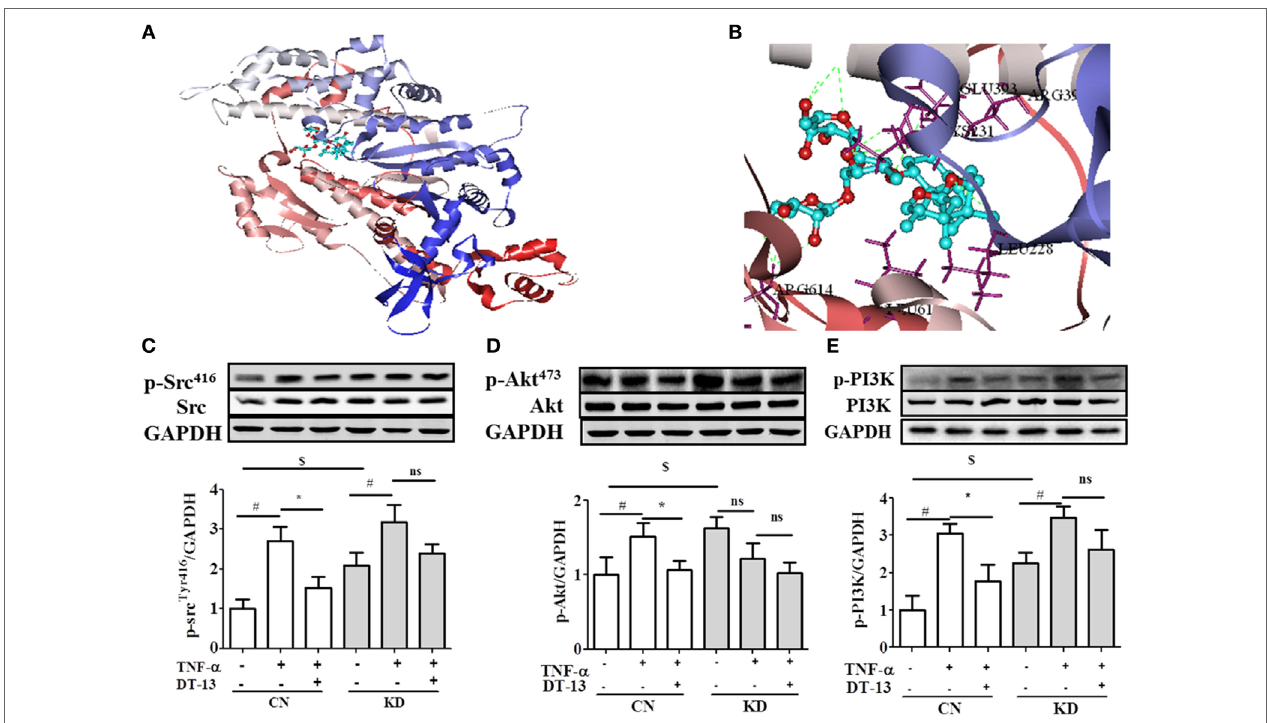
FigUre 6 | Non-muscle myosin IIA (NMIIA) plays an important role in DT-13-attenuated TNF- α -induced endothelial hyperpermeability and related pathways. (a) The complex of DT-13 and proteins of NMMHC IIA. (B) 5 Å residues of NMMHC IIA around DT-13. Western blotting analysis for the effect of DT-13 on (c) Src, (D) Akt, and (e) PI3K. Endothelial cells were pretreated with NMIIA siRNA for 43 h before addition of 1 µM DT-13 for 1 h and then incubated with TNF- α for another 4 h for Western blot analysis. The data represent the mean ± SD from three experiments. # P < 0.01 vs. the control group; * P < 0.05, ** P < 0.01 vs. the TNF- α